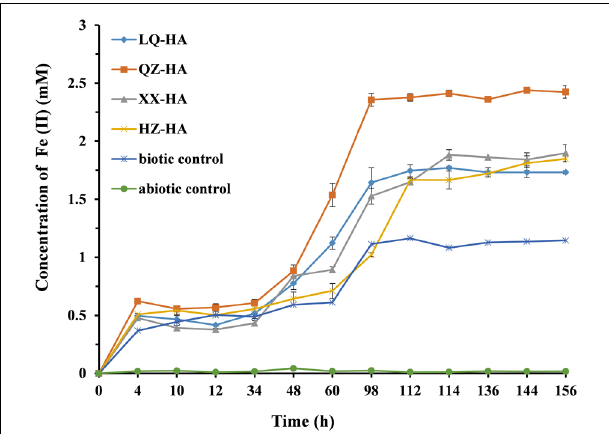
FIGURE 5 | Production of total Fe(II) during the microbial reduction of FeOOH conducted by MR-1 in the presence of HAs of different origins (LQ-HA, XX-HA, QZ-HA, and HZ-HA) within 156 h. Data show the mean values of triplicate cultures, and vertical bars show the difference in triplicate